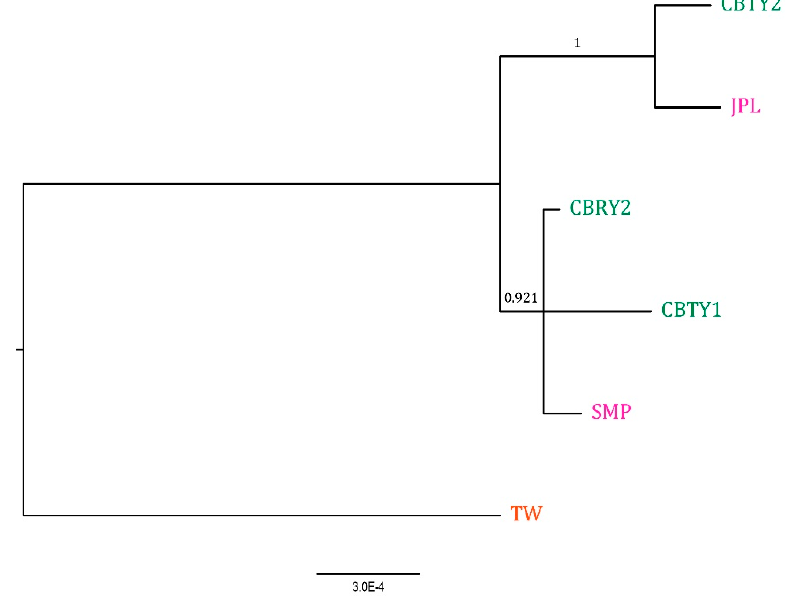
Figure 6. Phylogenetic analysis of C. argyrophylla populations in different locations of China. Bayes posterior probabilities are shown next to the nodes. The fonts in purple colors indicate populations from Chenzhou city; those in green colors indicate populations from Chengbu county; the only font in orange color indicates the population from Taiwan province. The number at the bottom of the figure is used for measuring genetic distance. CBTY1, CBTY2 and CBRY2 were collected from Chengbu County of the Hunan Province. JPL and SMP were collected from Chengzhou City of the Hunan Province. TW was obtained from a previously published study, in which the samples were collected from Taipei City of the Taiwan Province.